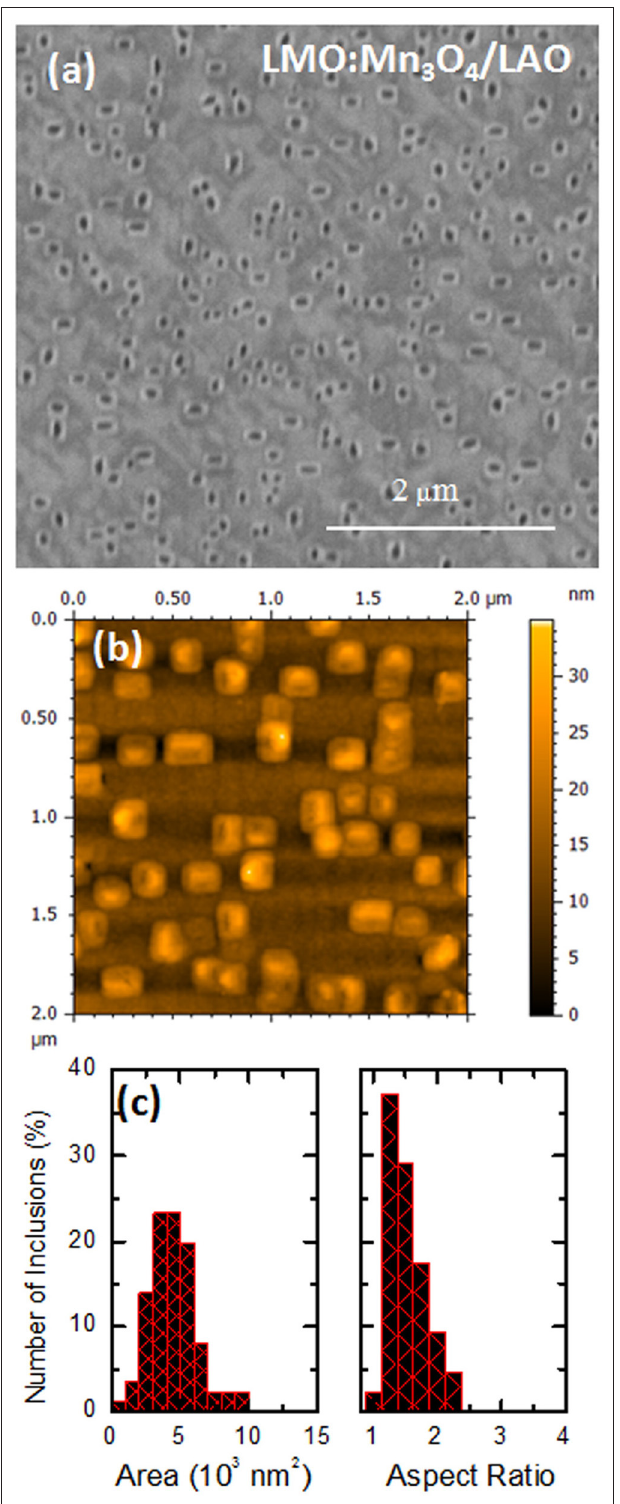
FIGURE 2 | Surface morphology of 40nm thick LMO nanocomposite films grown on top of LAO substrate (A) SEM image (B) AFM image (C). Statistical distribution analysis of size and shape of the Mn 3 O 4 inclusions observed in SEM images.